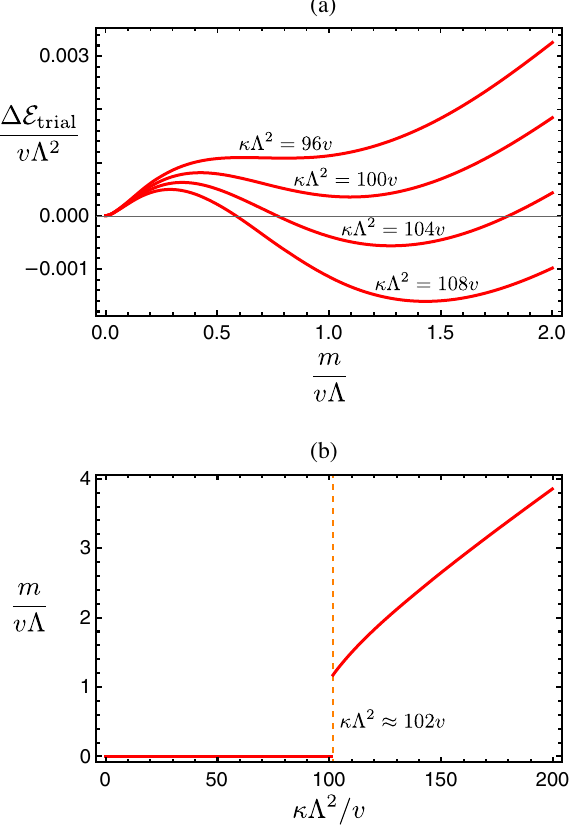
FIG. 13. (a) Variational energy difference Δ E [Eq. (A14)] trial versus mean-field mass m for varying interaction strengths κ in the continuum model given by Eqs. (16) and (17). For κ Λ 2 ≳ 102 v , the variational energy is minimized with nonzero m , signaling the spontaneous opening of a gap. (b) Optimal mass as a function of interaction strength. In the normalizations adopted above, v is the velocity and Λ is the